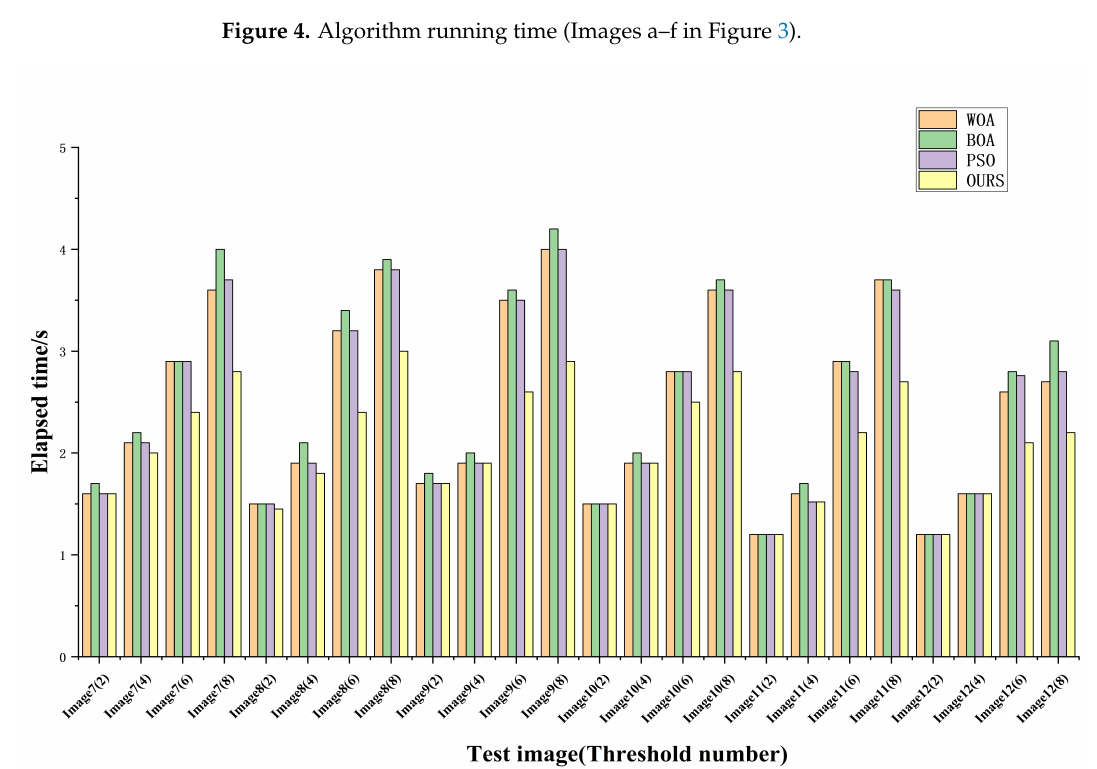
Figure 5. Algorithm running time (Images g–l in Figure